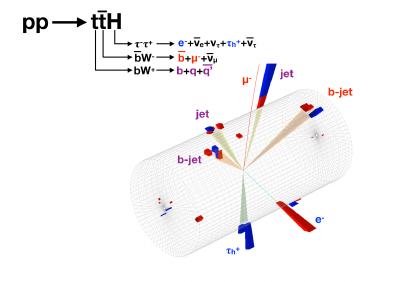
Figure 1. Decay of a top quark to a W boson and a b quark. The W boson can then decay to two other quarks, making a jet triplet [2].